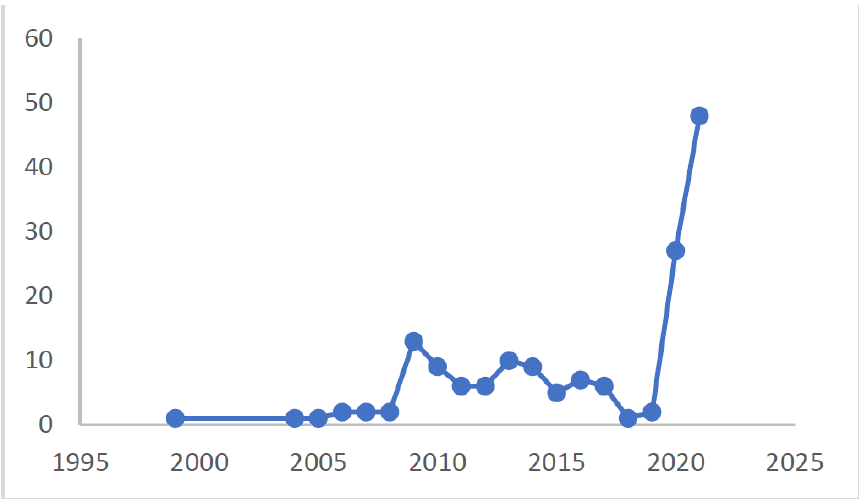
Figure 2. Evolution of publications by year.